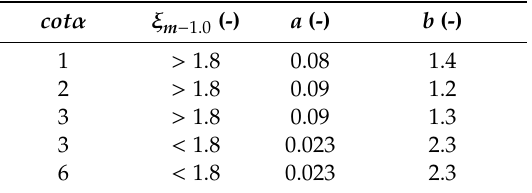
Table 2. Regression coe ffi cients a and b according to Equations (A4) and (A5) for corresponding smooth